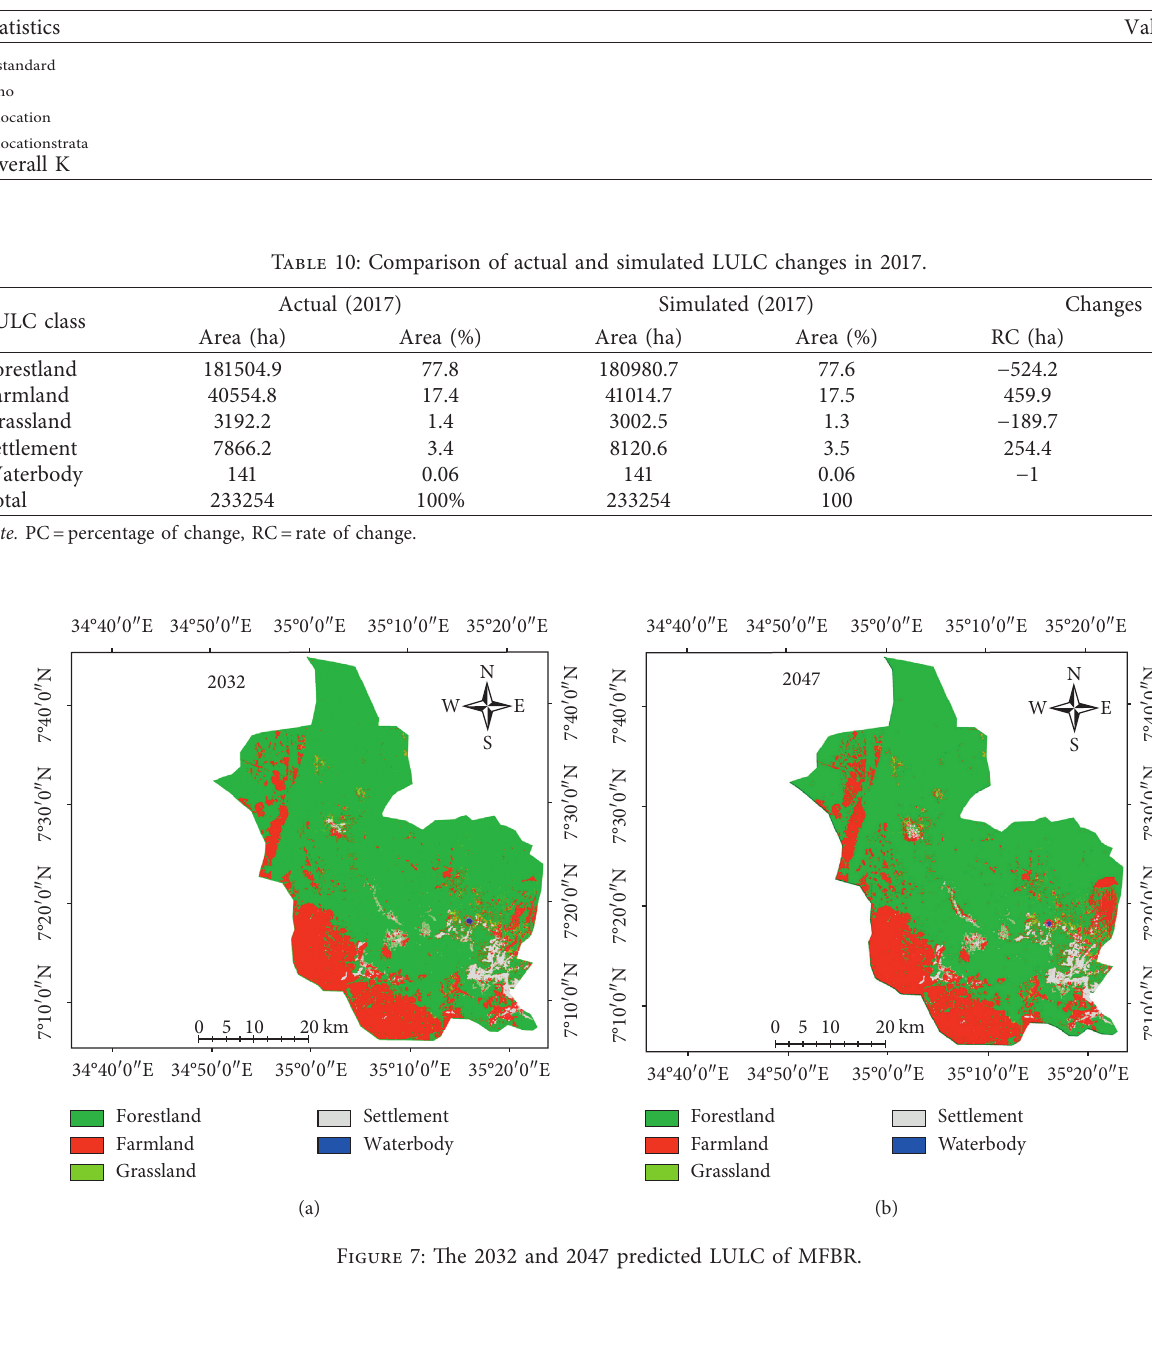
Table 11: LULC area change (ha) from 2017 to 2047of